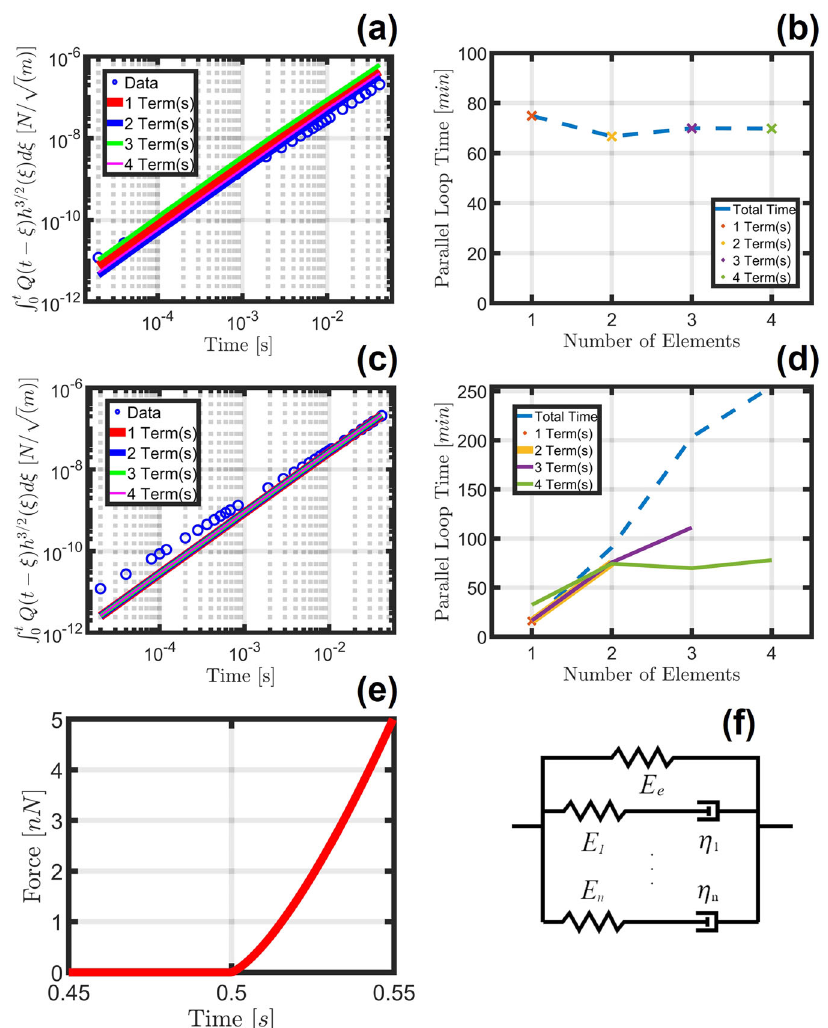
Fig. 2 Performance comparison for the iterative and open-search methodologies. The fi t performance and computational requirements for the Open Parameter Search method ( a and b ), and the Iterative Term Introduction method ( c and d ) are shown, in addition to the original force curve ( e ) generated using the Generalized Maxwell Viscoelastic model ( f ) with parameters provided in Supplementary Table 1 and simulated according to the methods described in Supplementary Discussion 5. The dashed blue lines in b and d represent the total time necessary to acquire a set of best- fi t parameters for a model with the number of elements indicated — i.e., for four elements, the Iterative Term Introduction method would require just over 250 min to run the fi tting for terms 1 − 4, while the open parameter search method needs only the time indicated for the 4-term fi t (approximately 70 min). The fi tting time for the iterative approach using 1 term is lower than the corresponding fi t for the open parameter search method because in the former the elastic term is fi rst fi t independently, and then fed forward to the 1-term parameterization attempt. The standard error for each model con fi guration is provided in Supplementary Table 2. Note that fi t quality ( a and c ) has been visualized using the Generalized Maxwell Viscoelastic model convolution integral of the fi t (cid:1) (cid:3) R 3 2 d ζ ) against the normalized dataset ( 3 1 (cid:2) ν ð Þ t ffiffi Q t (cid:2) ζ ð Þ (cid:3) h ζ ð Þ p F t ð Þ ( 0 R 8